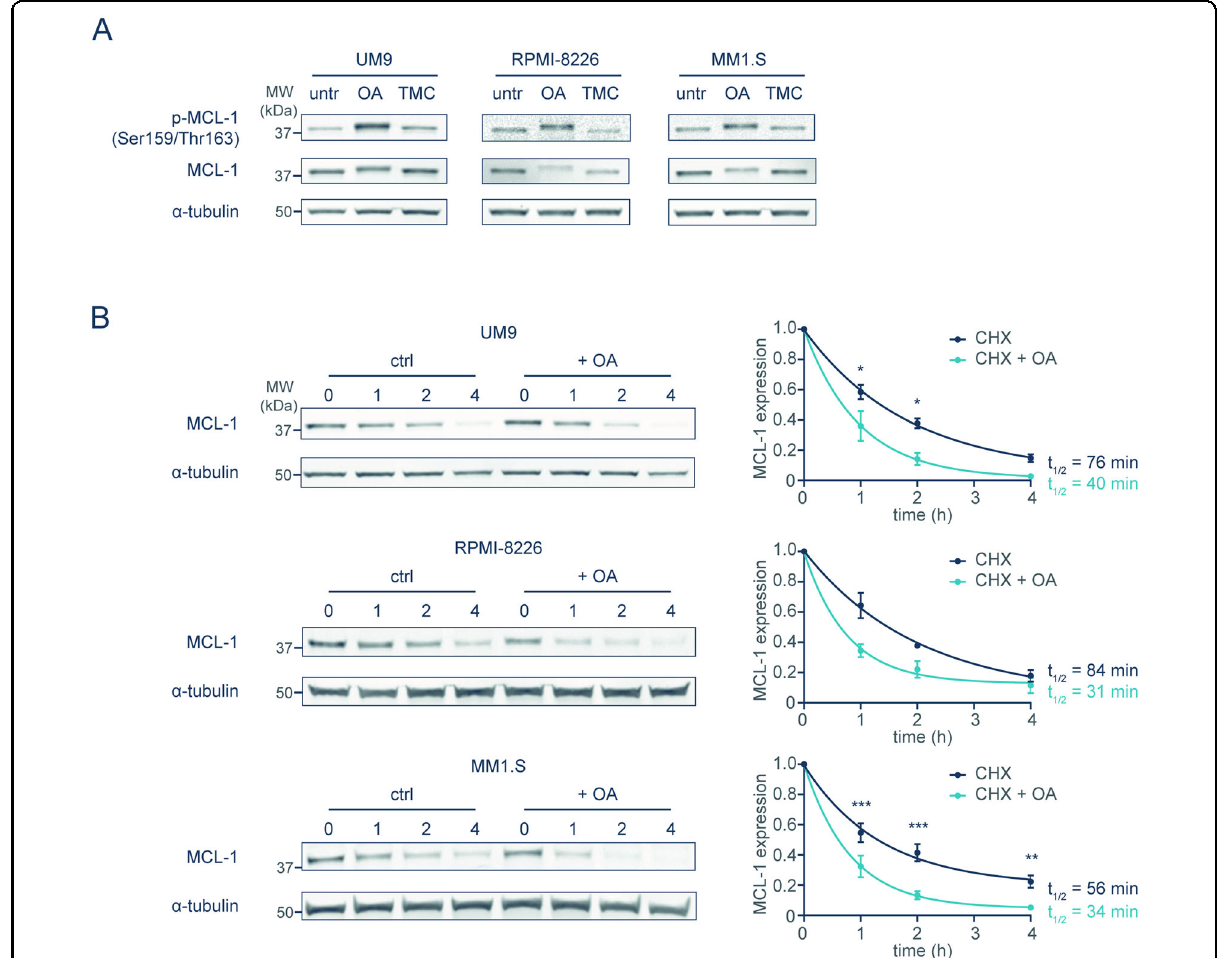
Fig. 5 PP2A inhibition leads to phosphorylation and destabilization of MCL-1. A Phosphorylation of MCL-1 (residues Ser159/Thr163) after treatment of MM cell lines with long MCL-1 half-life for 2 h with either 100 nM OA or 1 µM PP1 inhibitor tautomycetin (TMC). All samples were treated in the presence of 20 nM proteasome inhibitor bortezomib and 10 μ M Q-VD-OPh in order to prevent proteasomal degradation of phosphorylated MCL-1, while maintaining cell viability. B MCL-1 half-life after treatment with OA. Experiments and analyses were performed as in Fig. 1A – C. OA- treated samples received 2 h pretreatment with OA, and OA remained present during CHX treatment. Graphs show averages of three independent replicates